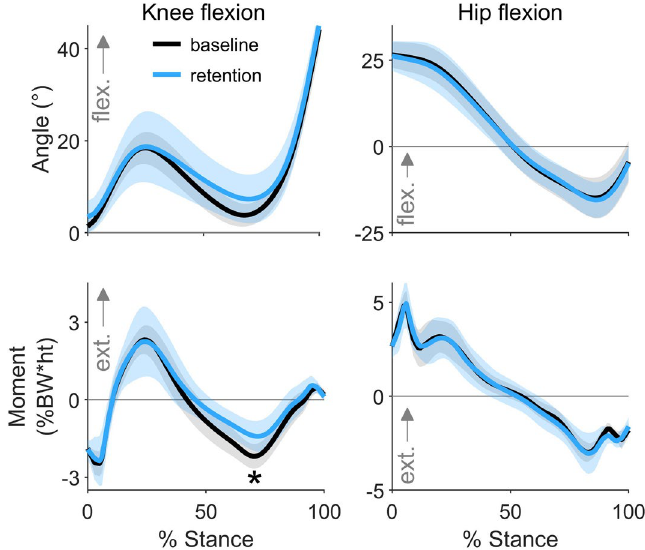
Figure 7. Changes in knee and hip mechanics. The mean (line) and standard deviation (shading) of knee and hip kinematics and kinetics for the participants who retained a reduction in their late-stance gastrocnemius activation during the retention trial (n = 8). During the retention trial, participants walked with a smaller late- stance knee flexion moment (*p = 0.015, paired t